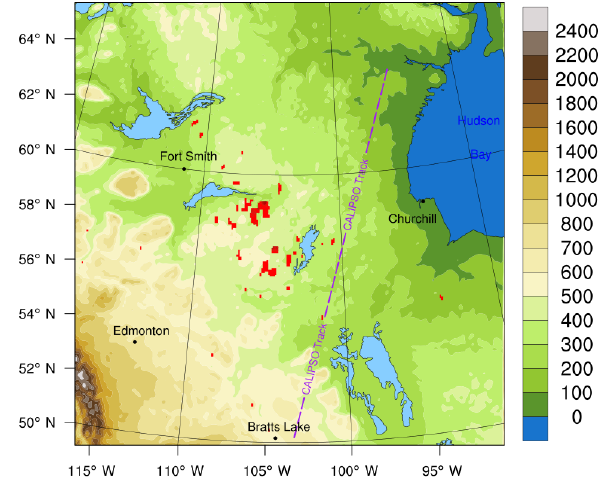
Figure 3. Simulation domain with model orography without the re- laxation area. The fire locations are marked in red for 15 July 2014. The CALIPSO overpass at around 09:20UTC, 16 July 2010 is de- noted by a purple